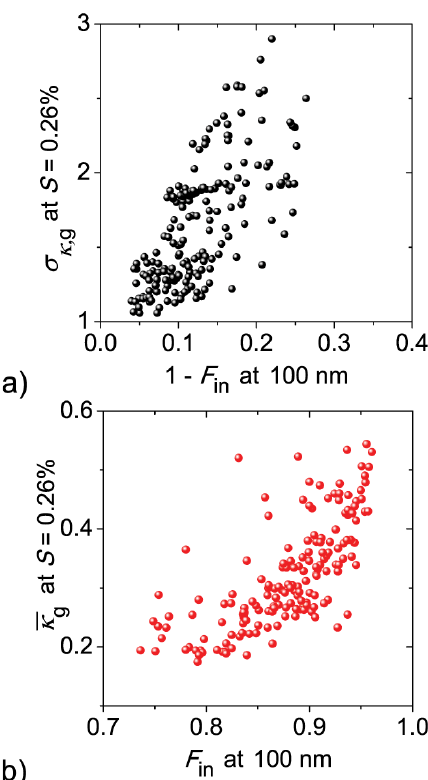
Fig. 2. Comparison of aerosol hygroscopicity and soot (NVP) mix- ing state parameters during the CAREBeijing-2006 campaign. The parameters κ g and σ κ, g were calculated from the aerosol hygroscop- icity (i.e., κ ) distribution measured at supersaturation S = 0 . 26% (Su et al., 2010); and F in was determined for particles of diameters at 100nm by the VTDMA measurements. Note that the mean ac- tivation diameter observed at S = 0 . 26% is 85nm (Gunthe et al.,